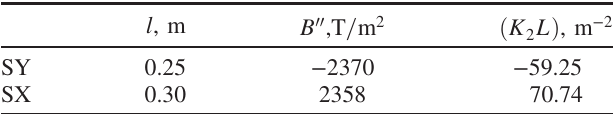
TABLE V. Main parameters of chromatic sextupoles.